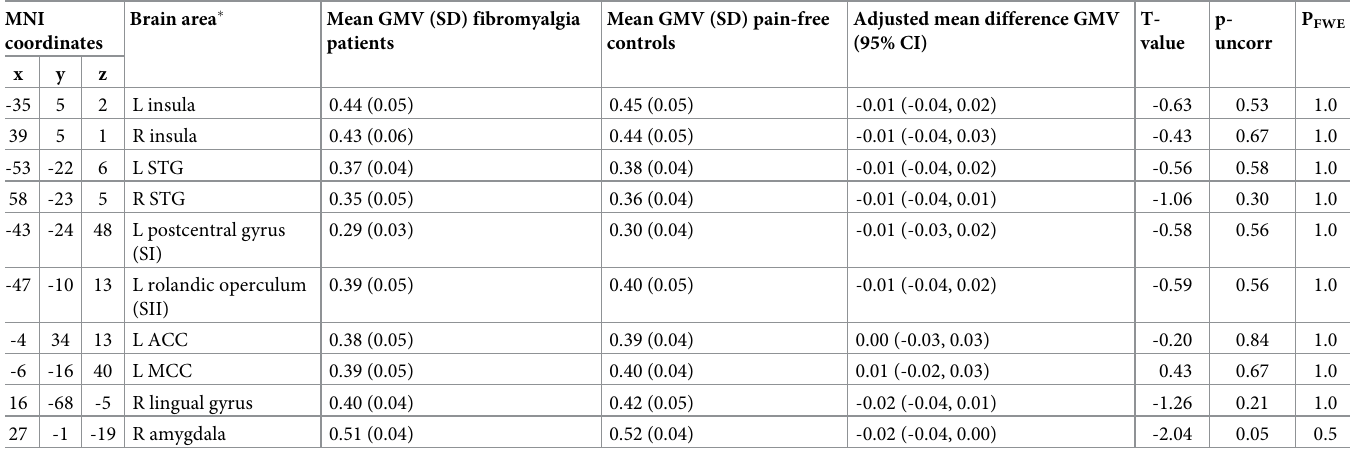
Table 3. Adjusted differences in grey matter volume between (GMV) 32 fibromyalgia patients and 32 pain-free controls in 10 pre-specified Regions of